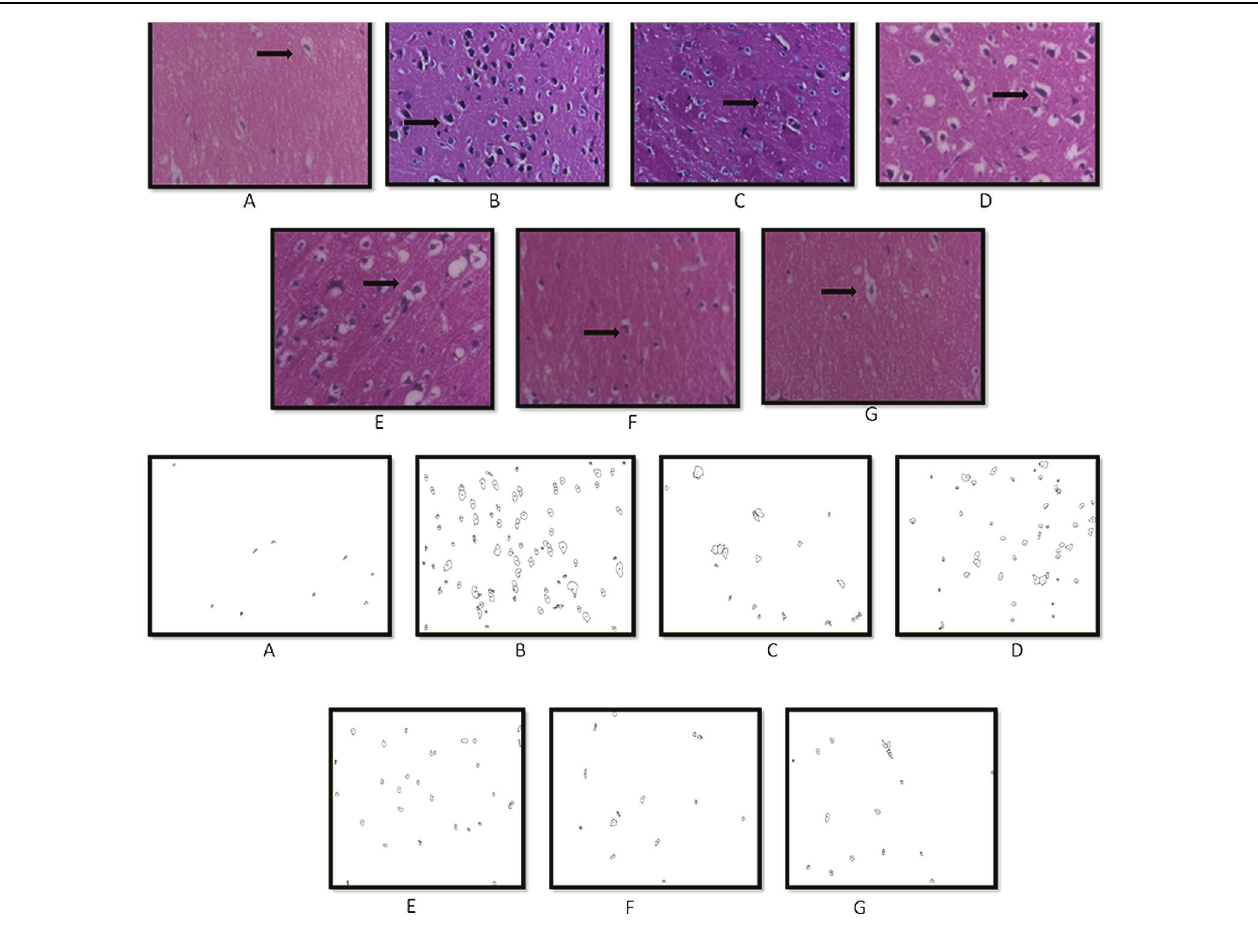
FIGURE 7 | Histopathological sections of rat brain stained with Hematoxylin and Eosin stain (H and E). Representative photomicrographs of CA regions of hippocampus sections (magnification 10X, from A–G ) of rat. (A) Sham: neurons are intact; (B) A β (1-42): inflammatory cells; (C) Gala (2): mild inflammation of neurons; (D) CoQ10 (20): moderate inflammation of neurons; (E) CoQ10 (40): moderate inflammation of neurons; (F) CoQ10 (20) + Minocycline (50): moderate inflammation of neurons; (G) CoQ10 (40) + Minocycline (100): mild inflammation of neurons (as shown by the